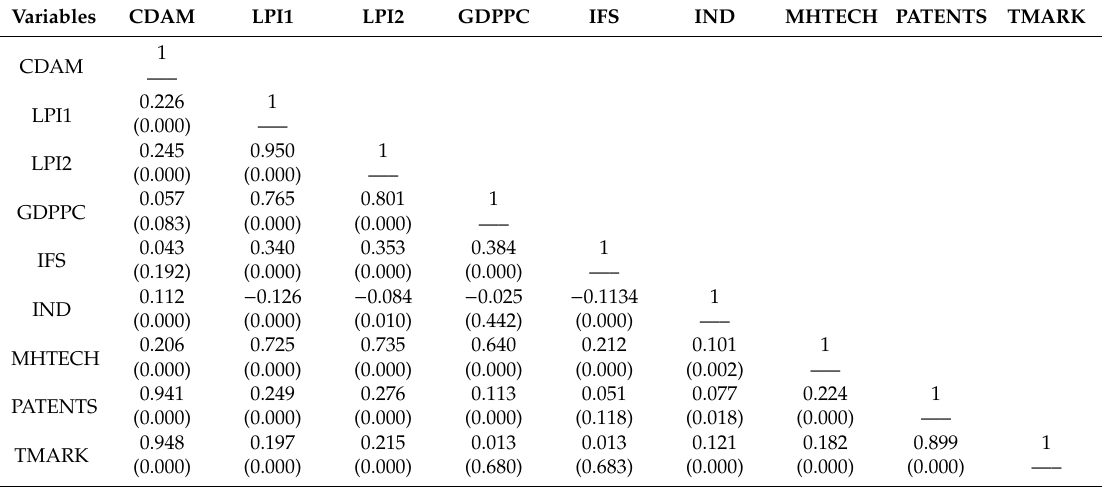
Table 4. Correlation